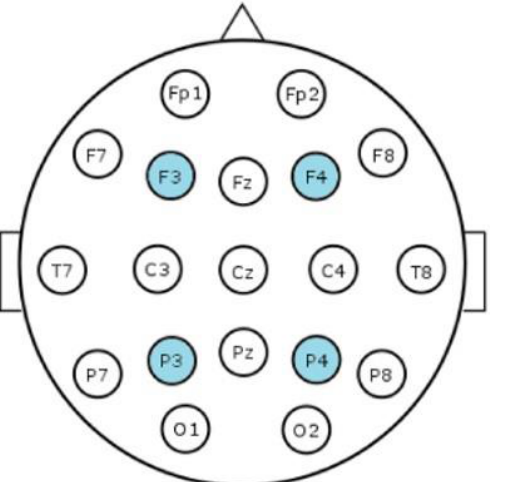
Figure 2. Positions of the electrodes. An illustration of the 10–20 system. The channels used in this study are highlighted in blue.